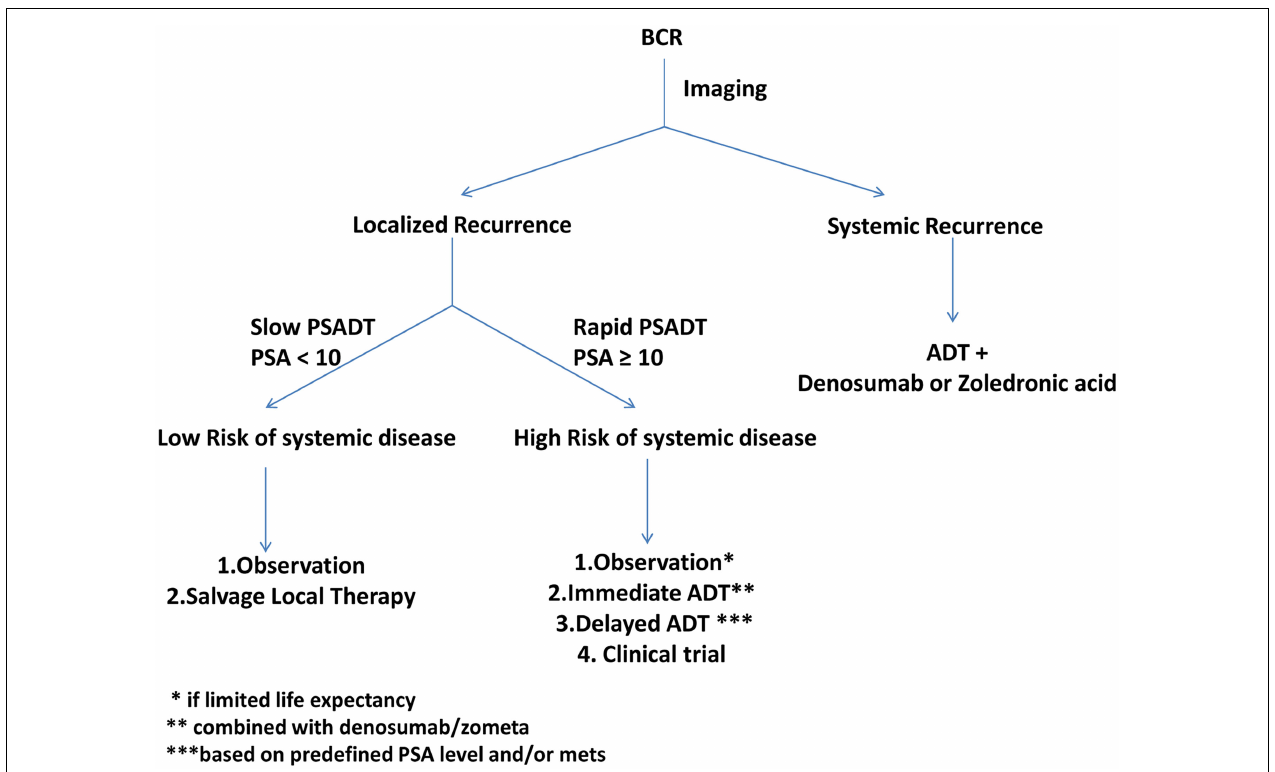
FIGURE 2 | Proposed algorithm for BCR management.